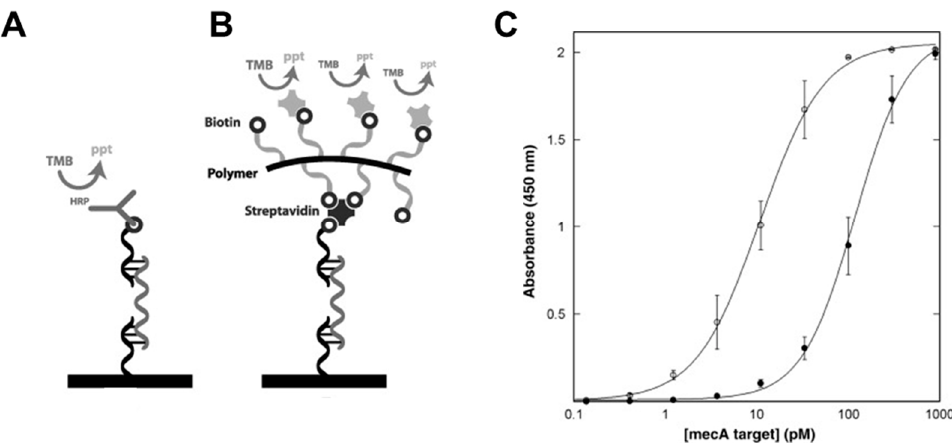
Figure 9. Schematic representation of standard detection and polymeric enzyme detection (PED)-enhanced detection of DNA hybridization. ( A ) Standard detection. The surface hybridized biotin-labeled oligonucleotide is detected by anti-biotin antibody / HRP conjugate reacted with the substrate—3,3’,5,5’-tetramethylbenzidine (TMB)—to produce a detectable signal. ( B ) PED detection. ( C ) The lower limit of detection of DNA hybridization using microtiter plate format. Various concentrations of a biotin-labeled, single-stranded target sequence from the mecA gene are hybridized to the mecA-specific capture probe immobilized onto microtiter wells. The signal is developed using standard detection (closed circles) or with the described PED polymer (open circles). Three experiments have been performed, each in triplicate (n = 9), and the mean absorbance reading ± 1 SD (error bars) is plotted [271]. Reproduced from Klonoski et al. (2010) with permission (Copyright © 2009 Elsevier Inc. All rights